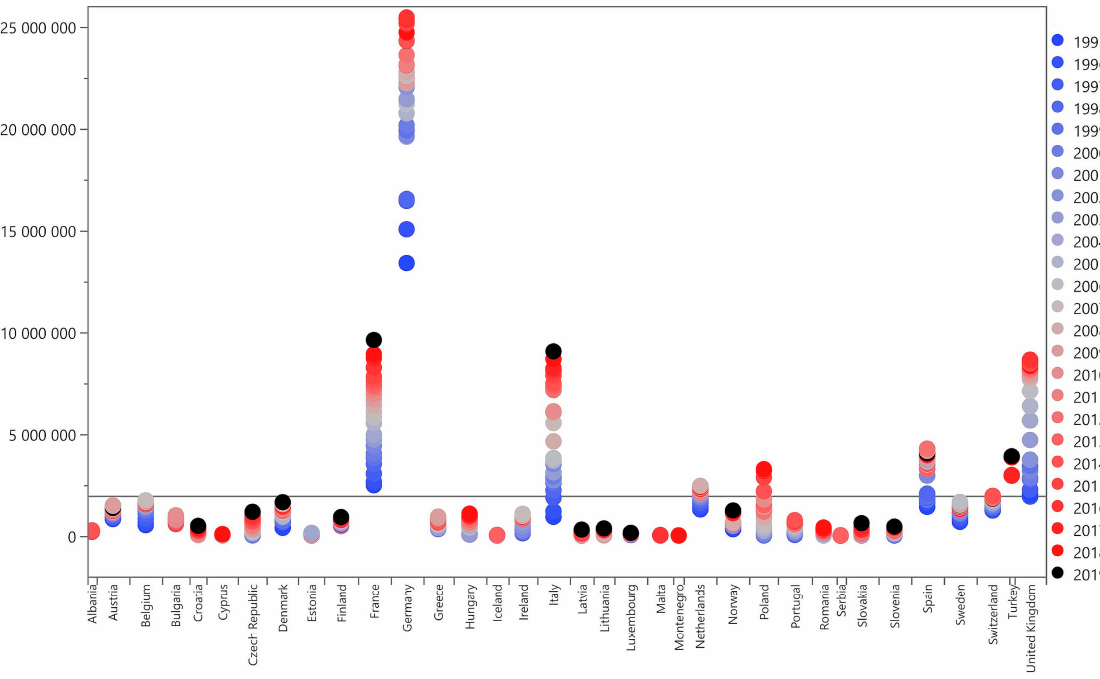
Figure 10. Recycling of municipal waste in the EU 1995–2019 .